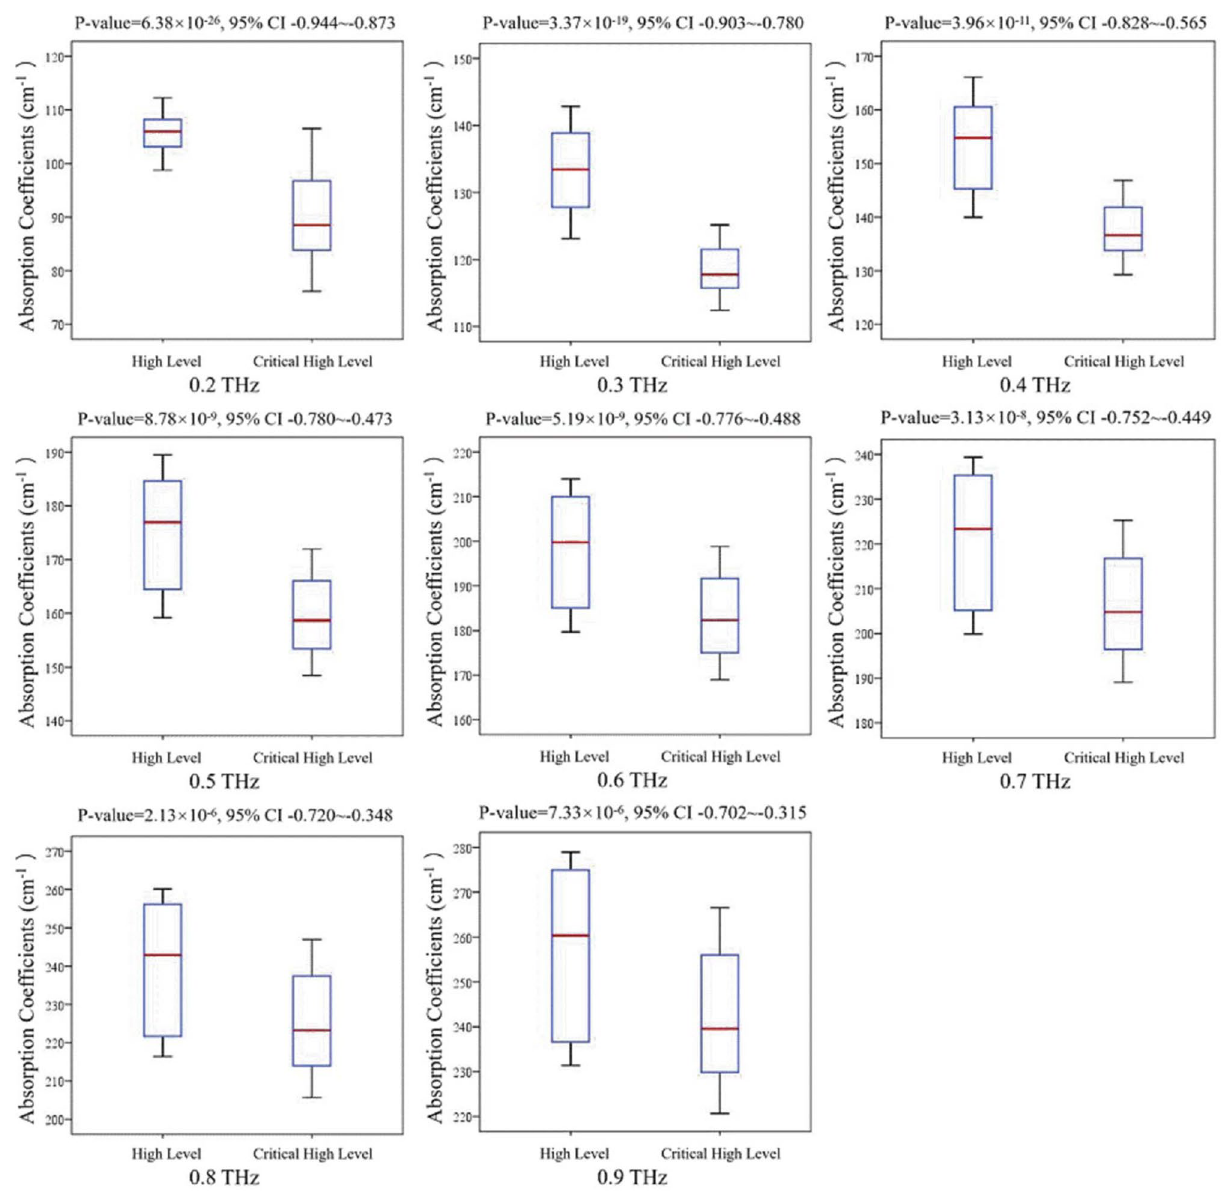
Figure 4. Two-tailed unpaired t-test between the THz absorption coefficients of the high-level group (n = 38) and critical high-level group (n = 55). The central red line indicates the median, the bottom and top edges of the box indicate the upper and lower quartiles, and the whiskers extend to the most extreme data points not considered outliers. P -values and confidence intervals (95% CI) for the difference in two groups are also